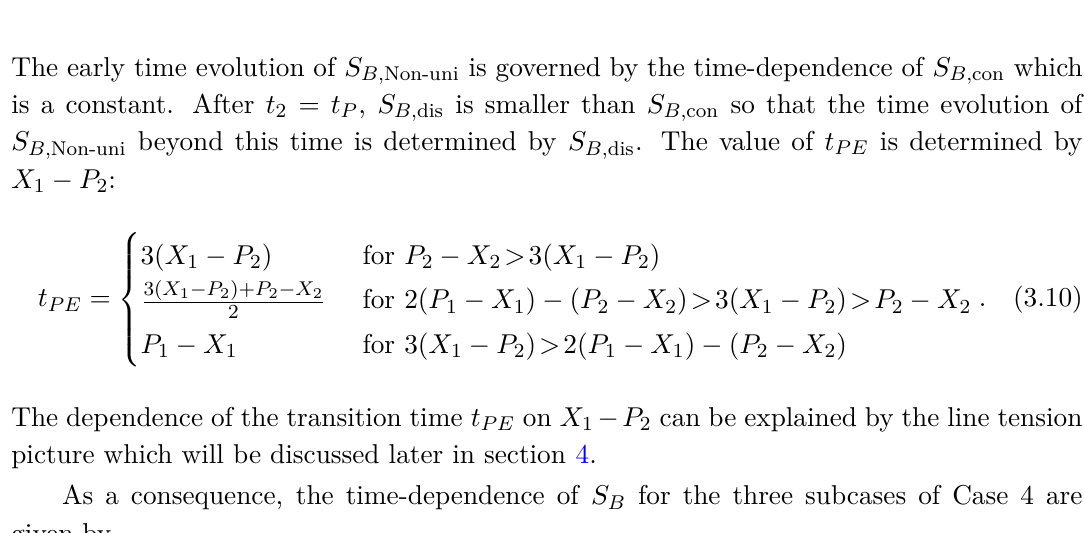
Figure 3: A cartoon of the trajectory of the operator. Orange dashed and dotted arrows illustrate the trajectory in t 2 of the operators, while the purple dashed and dotted arrows illustrate that the trajectory in t 1 . In the limits where t 1 approach 0 or ⇡ .